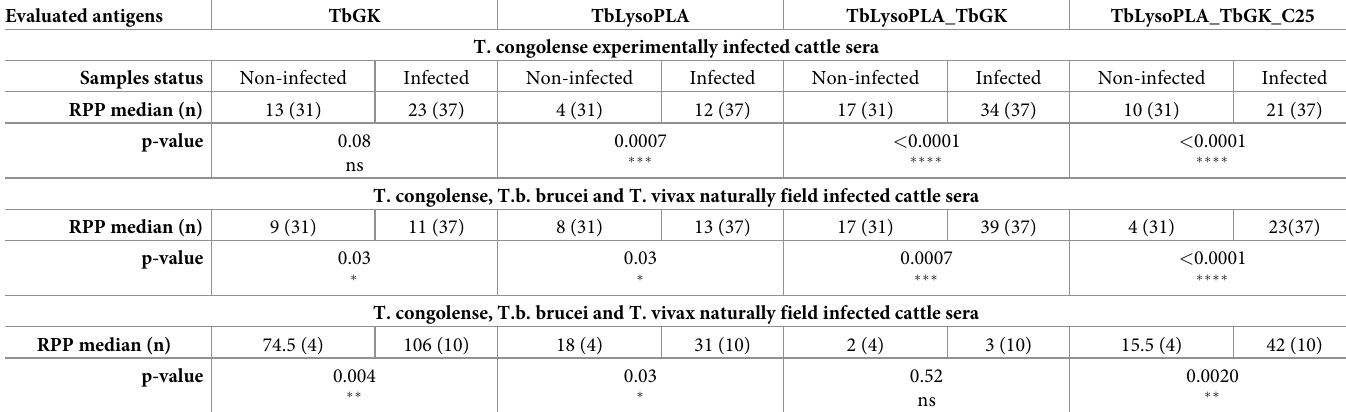
Table 3. Statistical analysis of infected vs. non-infected samples comparison for single protein and mixture